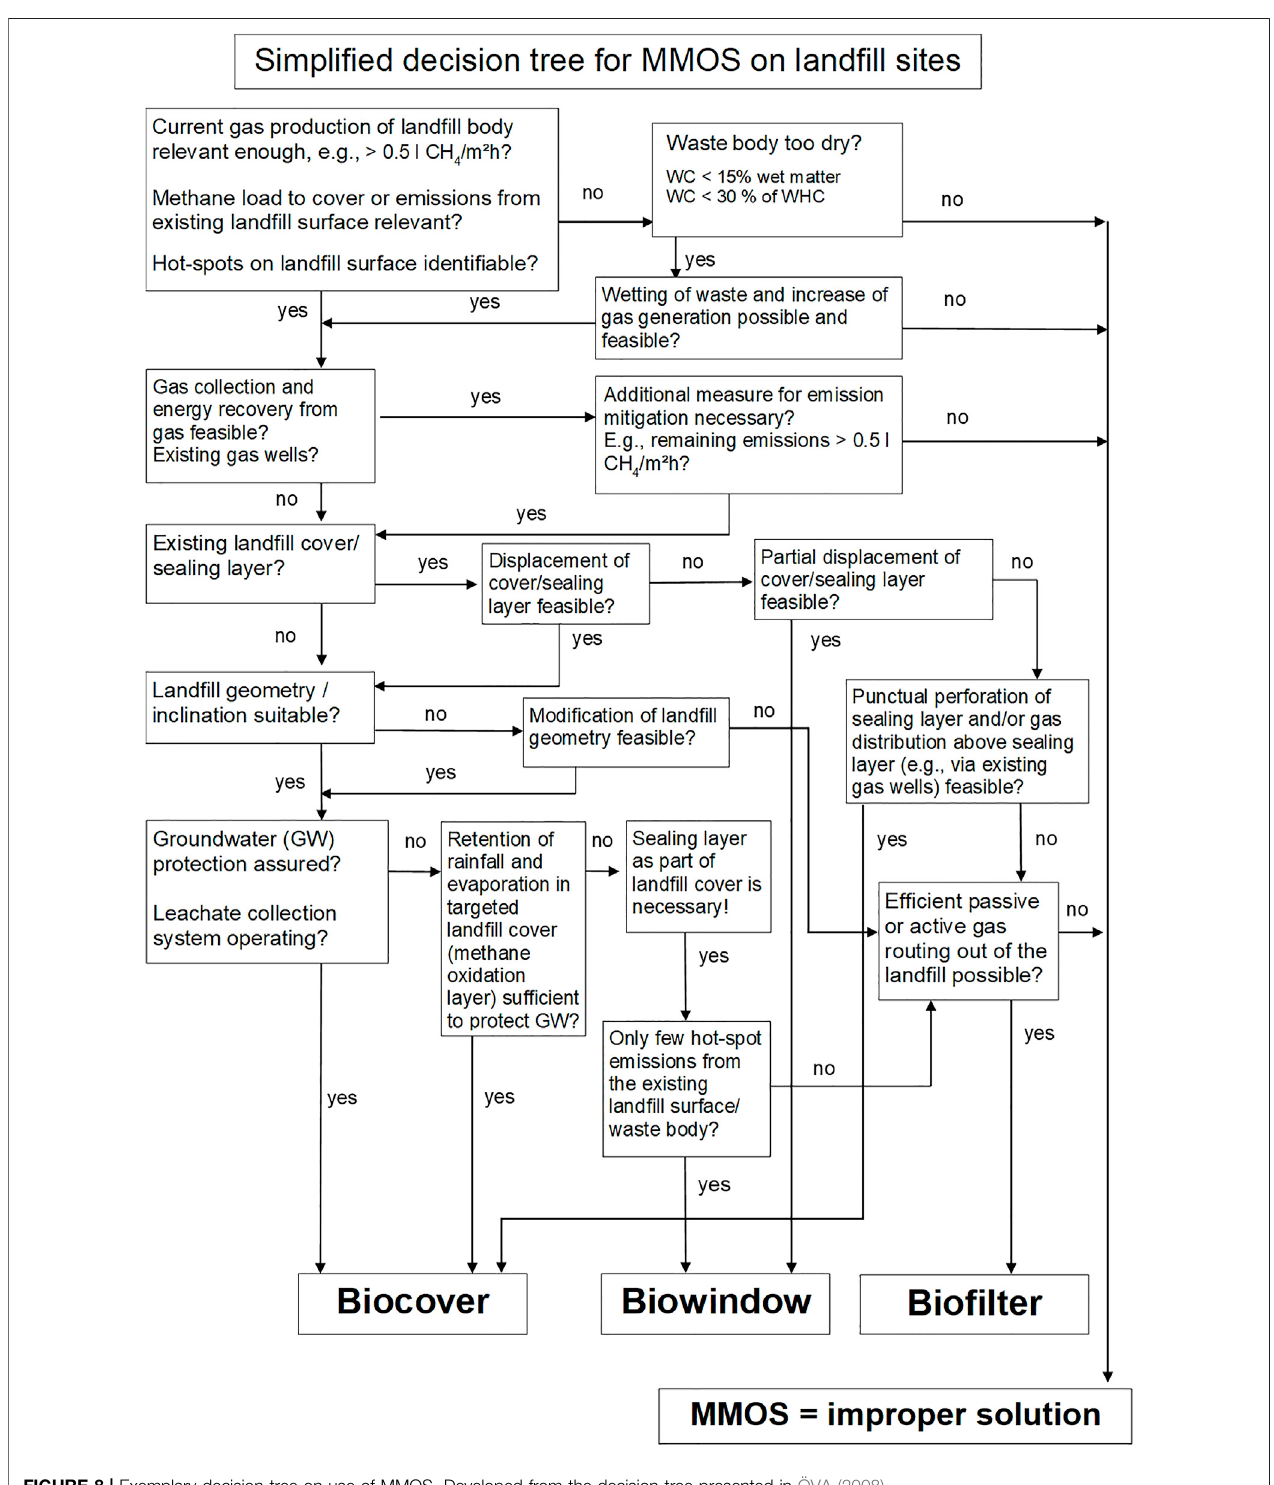
FIGURE 8 | Exemplary decision tree on use of MMOS. Developed from the decision tree presented in ÖVA (2008).